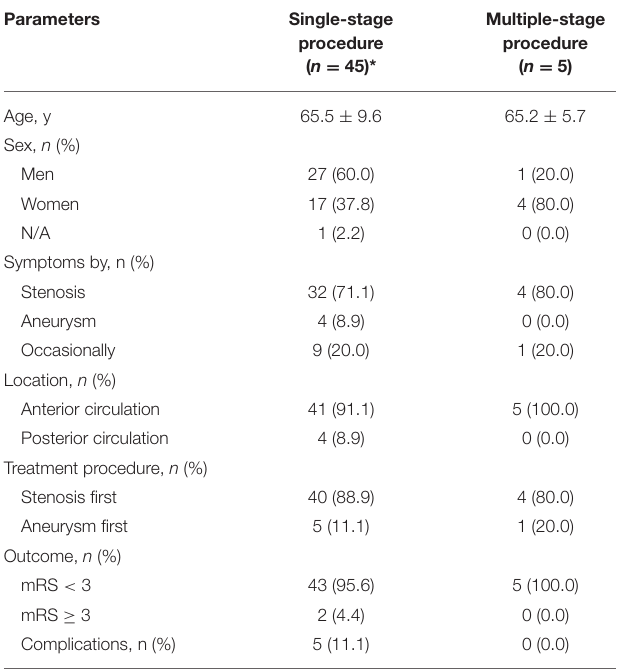
TABLE 4 | Characteristics and outcomes of the single-stage procedure and the multiple-stage procedure.